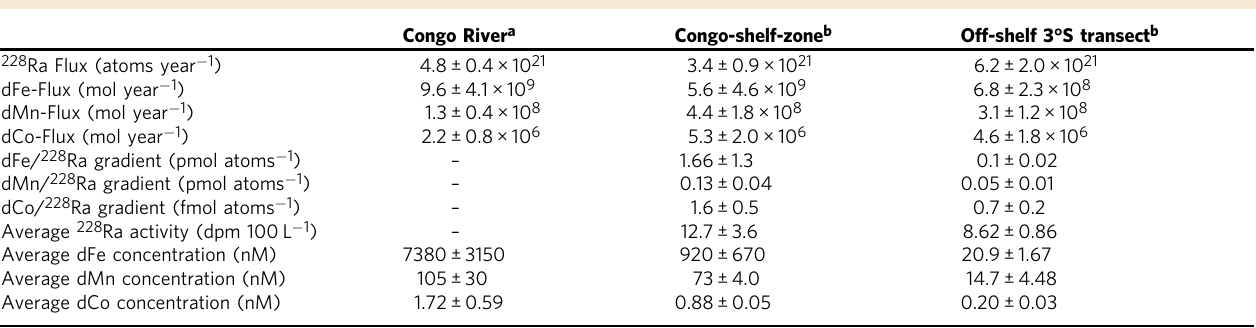
Table 1 Radium-228 and trace element fl